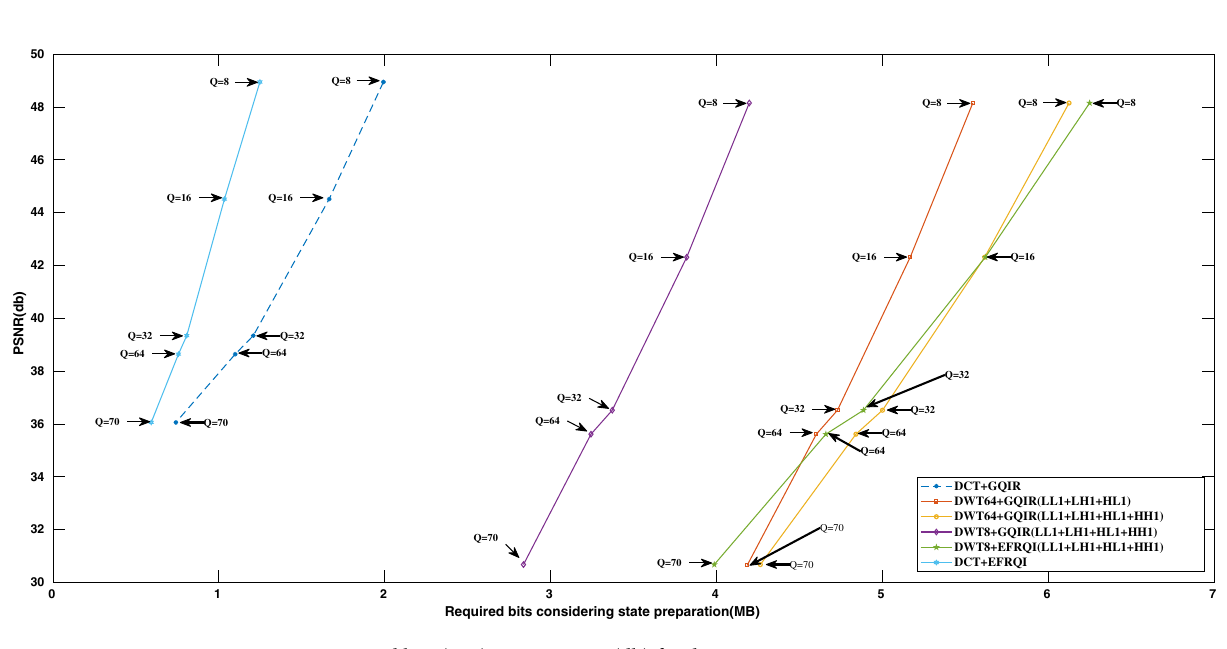
Figure 6. Required bits (MB) versus PSNR (db) for deer